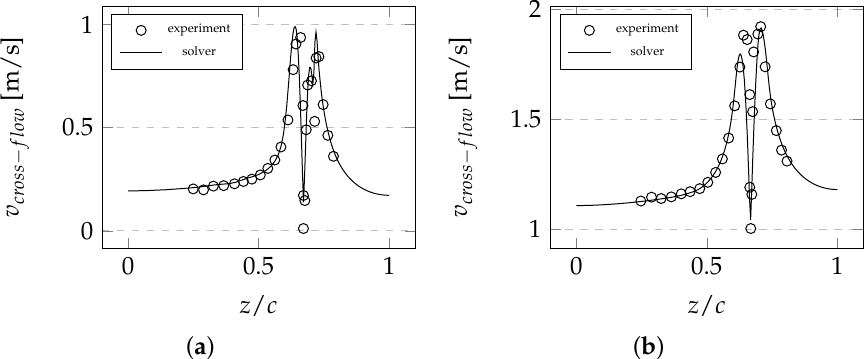
Figure 24. Cross-flow velocity along the span-wise direction at ( a ) x / c = 0 and ( b ) x / c = 0.24.